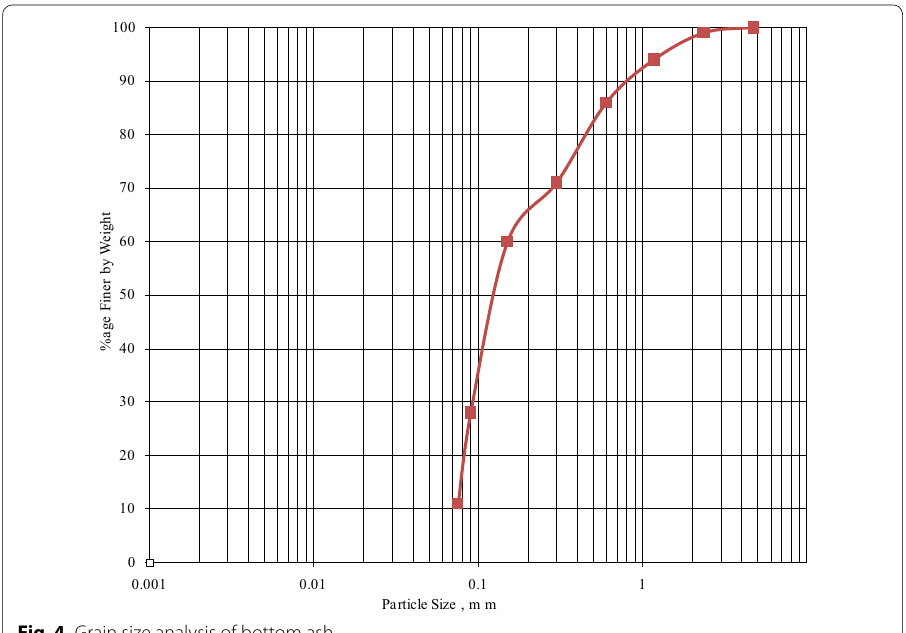
Fig. 4 Grain size analysis of bottom